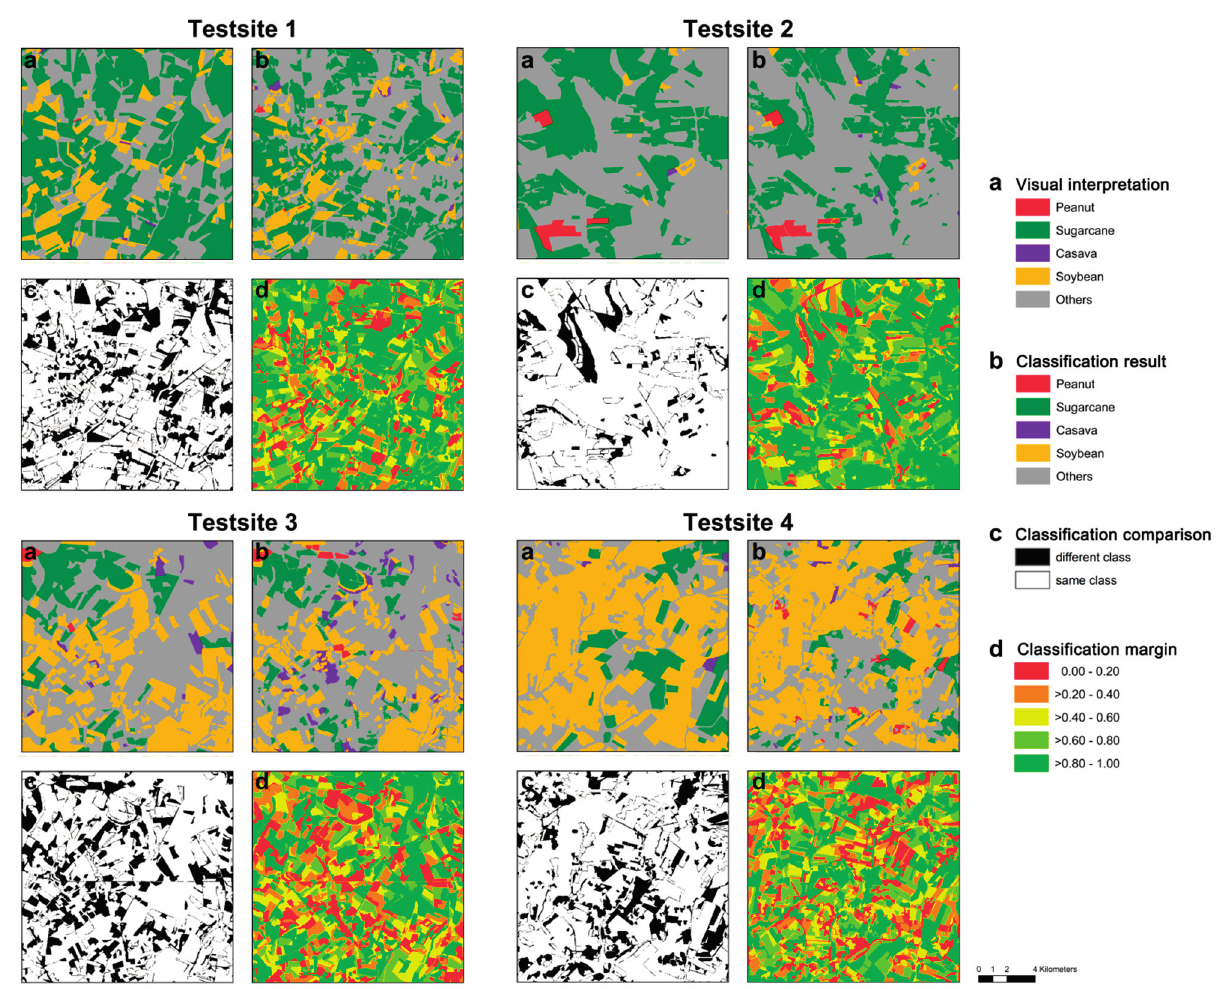
Figure 10. Evaluation of the “best” model (identified through reference samples A and B) against the manually delineated and visually interpreted test sites. The selected model was optimized against the (OOB) reference samples not the reference polygons. For each of the four test sites are shown: ( a ) the reference map, ( b ) the classification result, ( c) the agreement/disagreement between reference and classification, and ( d ) the classification margin. The higher the classification margin, the more confident the classifier “sees” its